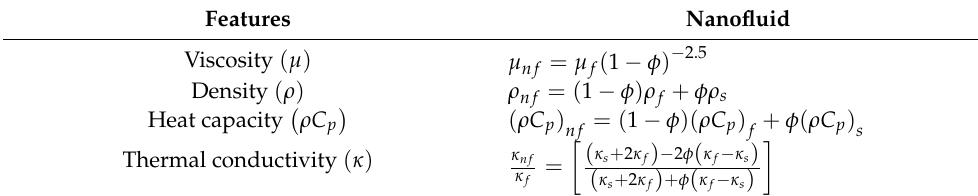
Table 1. Thermophysical features of the Oldroyd-B nanofluid.